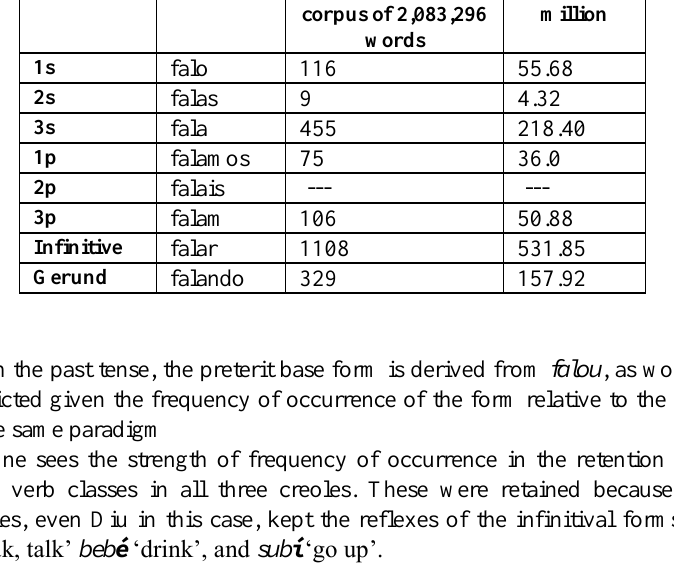
Table XIV. Frequency of present-tense forms and the infinitival form of falar in spoken Portuguese, according to Davies and Ferreira (2006-) Form Frequency in a